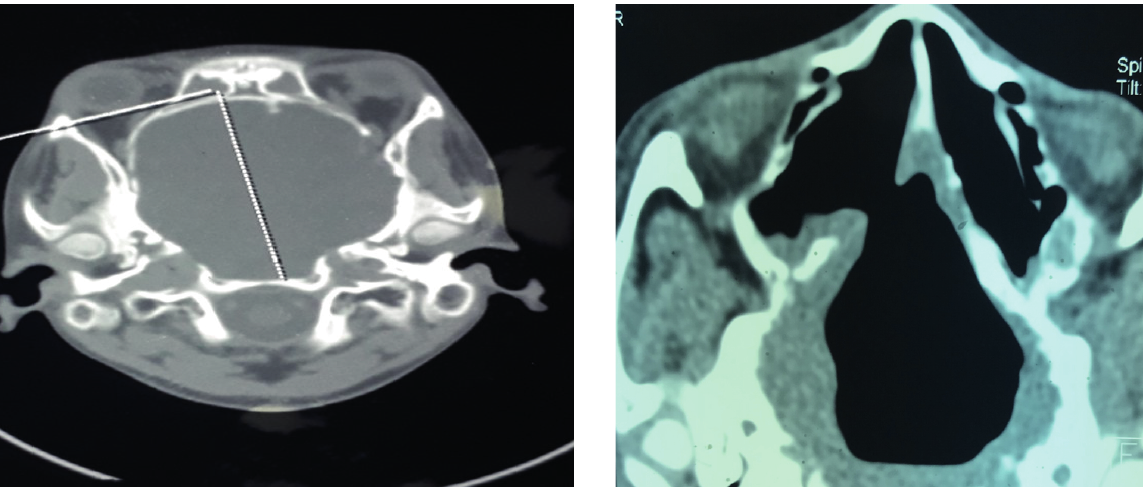
Figure 3. Sphenoid mass pushing back the eyes. Figure 4. Postoperative control